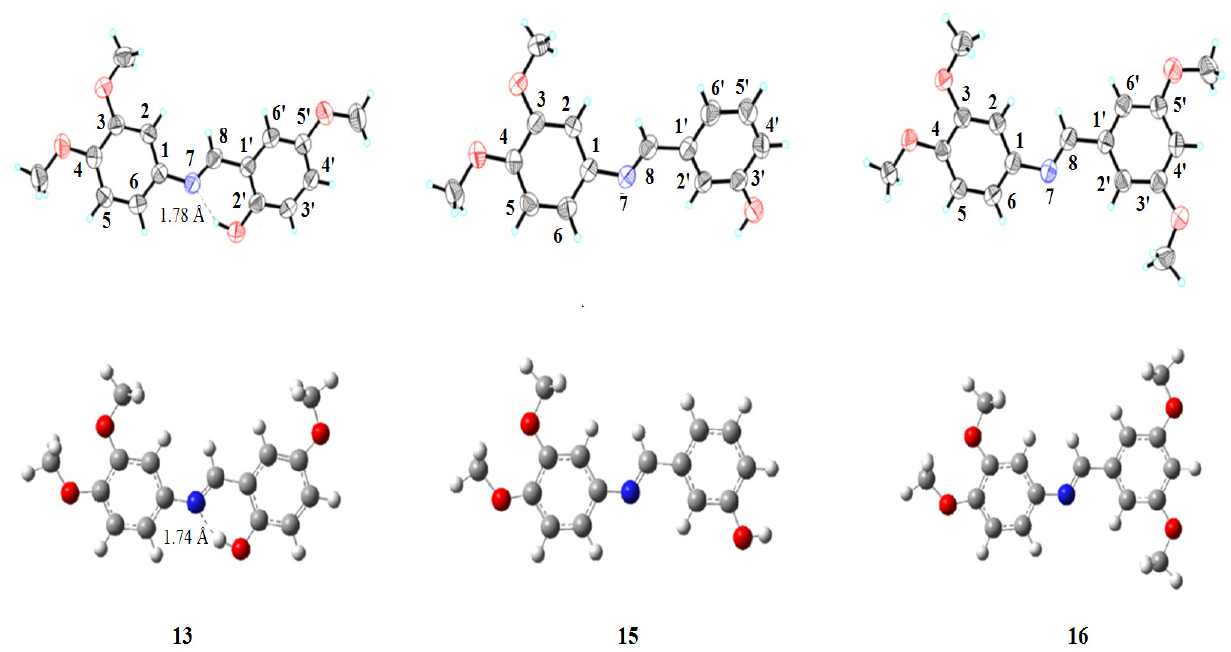
Figure 1. X-ray and optimized structures of compounds 13 , 15 and 16 .